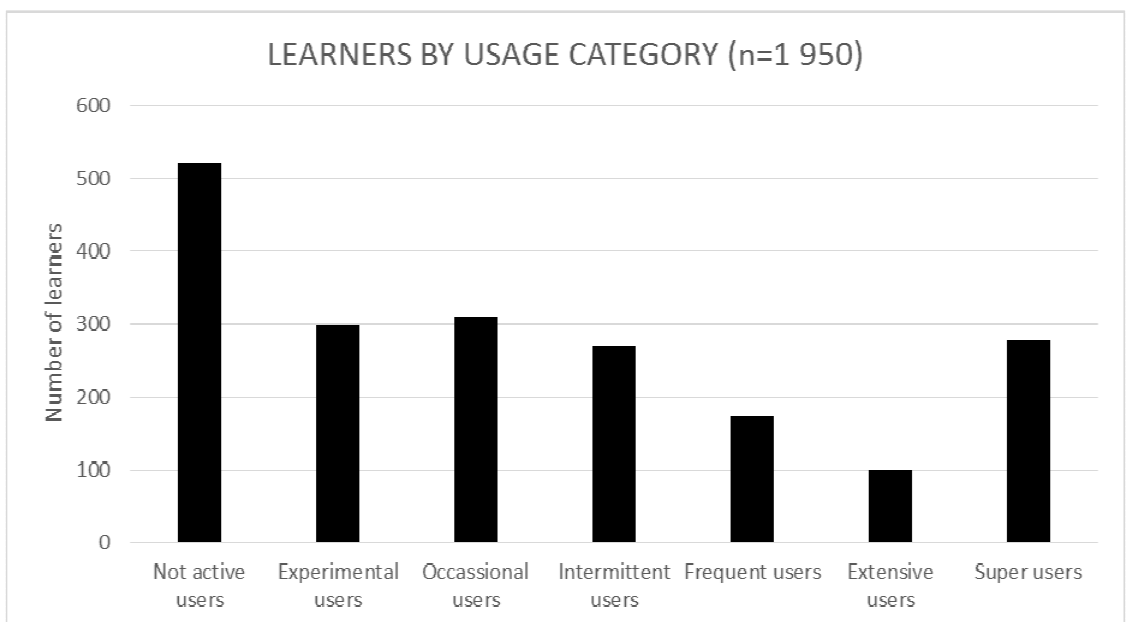
Figure 2 Group sizes of the categories of